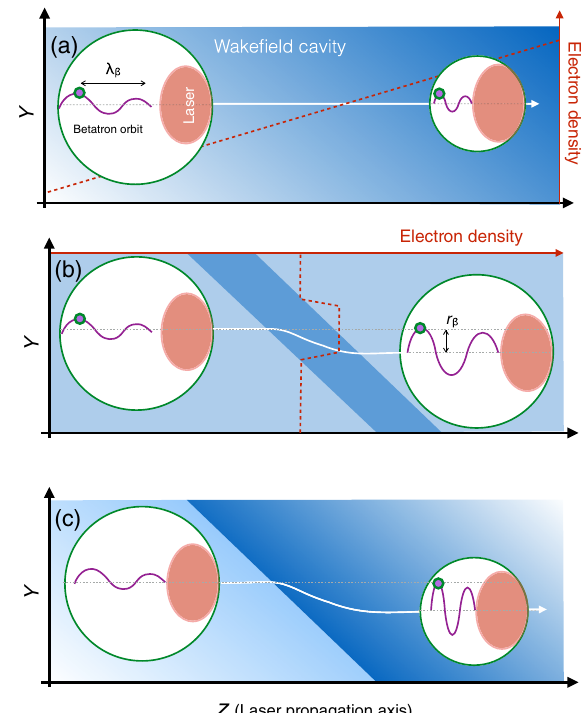
FIG. 1. Schematic representation of the role of density gra- dients to improve the efficiency of the betatron source. (a) A longitudinal density gradient results in an increase of γ due to rephasing and an increase of the betatron oscillation frequency ω β . (b) A sharp transverse density gradient results in a shift of the cavity axis due to the refraction of the laser pulse and in an increase of the oscillation amplitude r β . (c) Combining longi- tudinal and transverse density gradients increases simultaneously γ , ω r β , and β